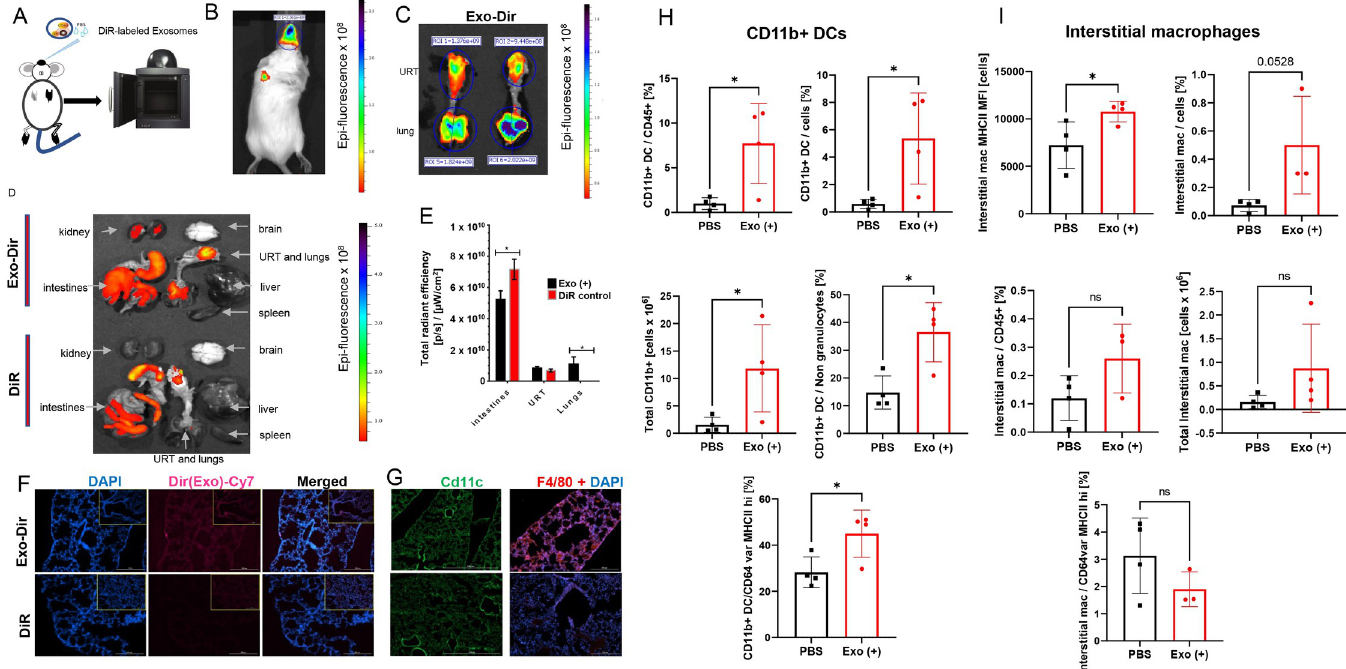
Fig 5. Biodistribution of exosomes derived from Salmonella -infected murine macrophages (RAW264.7 cells) administered intranasally to BALB/c mice. (A)-(B). Exosomes derived from Salmonella -infected macrophages were labeled with DiR (Exo-DiR), followed by washes to remove the free dye. A dose consisting of 20 μ g exosomes was administered intranasally (I.N.) to female BALB/c mice. At 24-hours post-administration, mice were anesthetized and imaged under IVIS Spectrum In Vivo System (Perkin-Elmer, USA). The whole-body image is shown, demonstrating a successful intranasal delivery. (C)-(E) Mice (B) were euthanized, and individual organs were harvested and subjected to IVIS analysis. Exosomes in the upper respiratory (URT) and lungs were evident as fluorescence of DiR-labeled exosomes ( Exo- DiR; C, D). For comparison, control mice received free DiR dye, which was also administered IN, and these animals underwent the same analysis (DiR). Other organs from control animals are also shown for comparison (D) . The total radiant efficacy was measured in intestines, URT, and lungs to quantify the Exo-DiR in individual organs (or free DiR dye). (F). Lung sections of mice immunized with Exo-DiR from S . Typhimurium-infected macrophages show exosomes in the lung regions, which are absent in the lungs of control animals receiving free DiR dye. DAPI staining was used to stain nuclei. (G). Lung sections of mice immunized with Exo-DiR from infected macrophages show the antigen-presenting cells’ infiltration to the pulmonary mucosa. Lung sections from mice were stained with anti-CD11c (FITC) or anti-F8/ 40 (APC) markers. (H)-(I). Graphs showing myeloid cell populations in the lungs of BALB/c mice treated with exosomes derived from Salmonella -infected macrophages or PBS control. Exosomes were isolated from Salmonella -infected macrophages by ultracentrifugation and stored in -80˚C after further use. A dose consisting of 40 μ g of exosomes was administered I.N. to female BALB/c mice. At 24-hours post-administration, mice were euthanized, and lungs collected for cell subpopulation analysis. Graphs show the percentage and numbers of CD11b + DCs populations (H) or interstitial macrophages and their MHCII expression (I) . Data on graphs are represented as mean ± SD. The p -values were determined by t-test, and indicated as follows (n � 3): * p � 0.05; ** p � 0.01; *** p � 0.001; **** p � 0.0001.